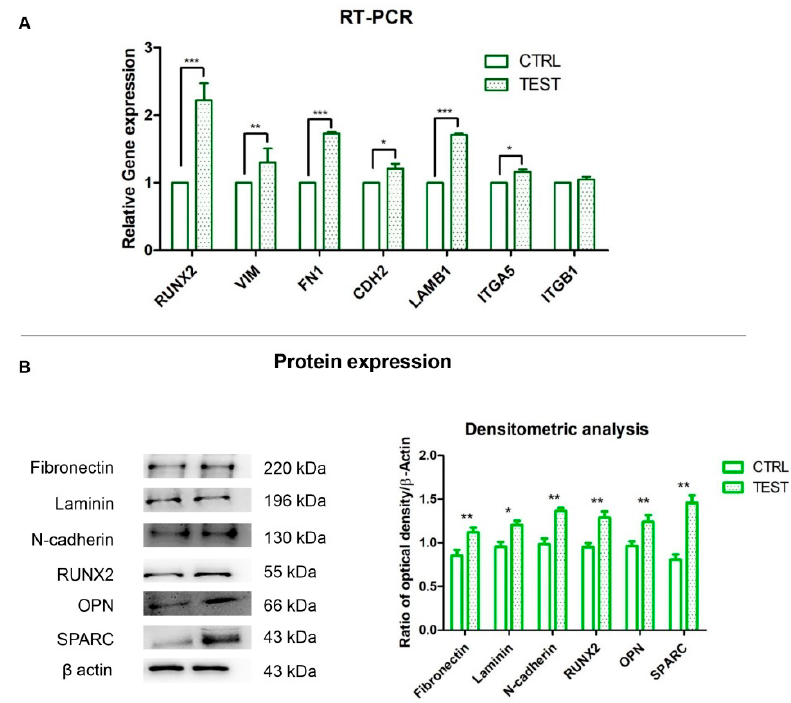
Figure 5. ( A ) Histograms of RT-PCR showed the mRNA levels of RUNX2, VIM, FN1, CDH2, LAMB1, ITGA5 and ITGB1 in hPDLSCs cultured on CTRL and TEST surface * p < 0.05; ** p < 0.01; *** p < 0.001. ( B ) Protein expression of Fibronectin, Laminin, N-cadherin, RUNX2, OPN and SPARC in hPDLSCs cultured on CTRL and TEST surface. Histograms represent densitometric measurements of proteins bands expressed as integrated optical intensity with the mean of three separate experiments. The error bars showed standard deviation ( ± SD). Densitometric values analyzed by ANOVA showed significant differences. * p < 0.05; ** p < 0.01.